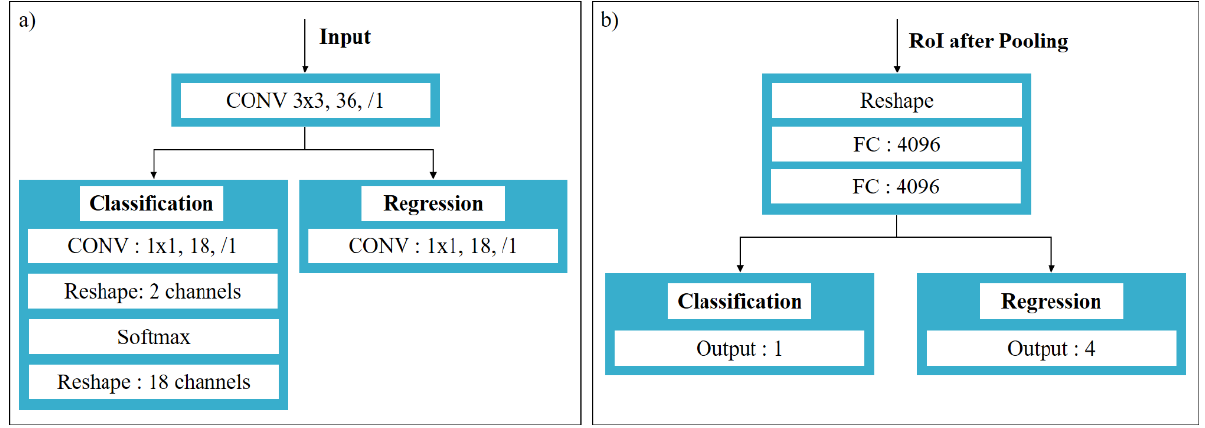
Figure 6. ( a ) RPN network structure; ( b ) RCNN network structure. The first layer of the RPN network goes through a 3 × 3 convolutional layer for deeper feature extraction. In the classification branch, a 1 × 1 convolution kernel is used to change the number of channels of the feature map to 18 to represent the classification probability values of the positive and negative samples of the 9 anchors. In order to use Softmax for binary classification, the number of channels is reshaped to two, and only the probability values of the positive and negative anchors are retained. After Softmax classification, the number of feature map channels is reshaped to 18 again, so that the binary classification probability values of the nine anchors are obtained. The loss function of this branch adopts the cross-entropy loss function commonly used in classification tasks, as shown in Equation (1):